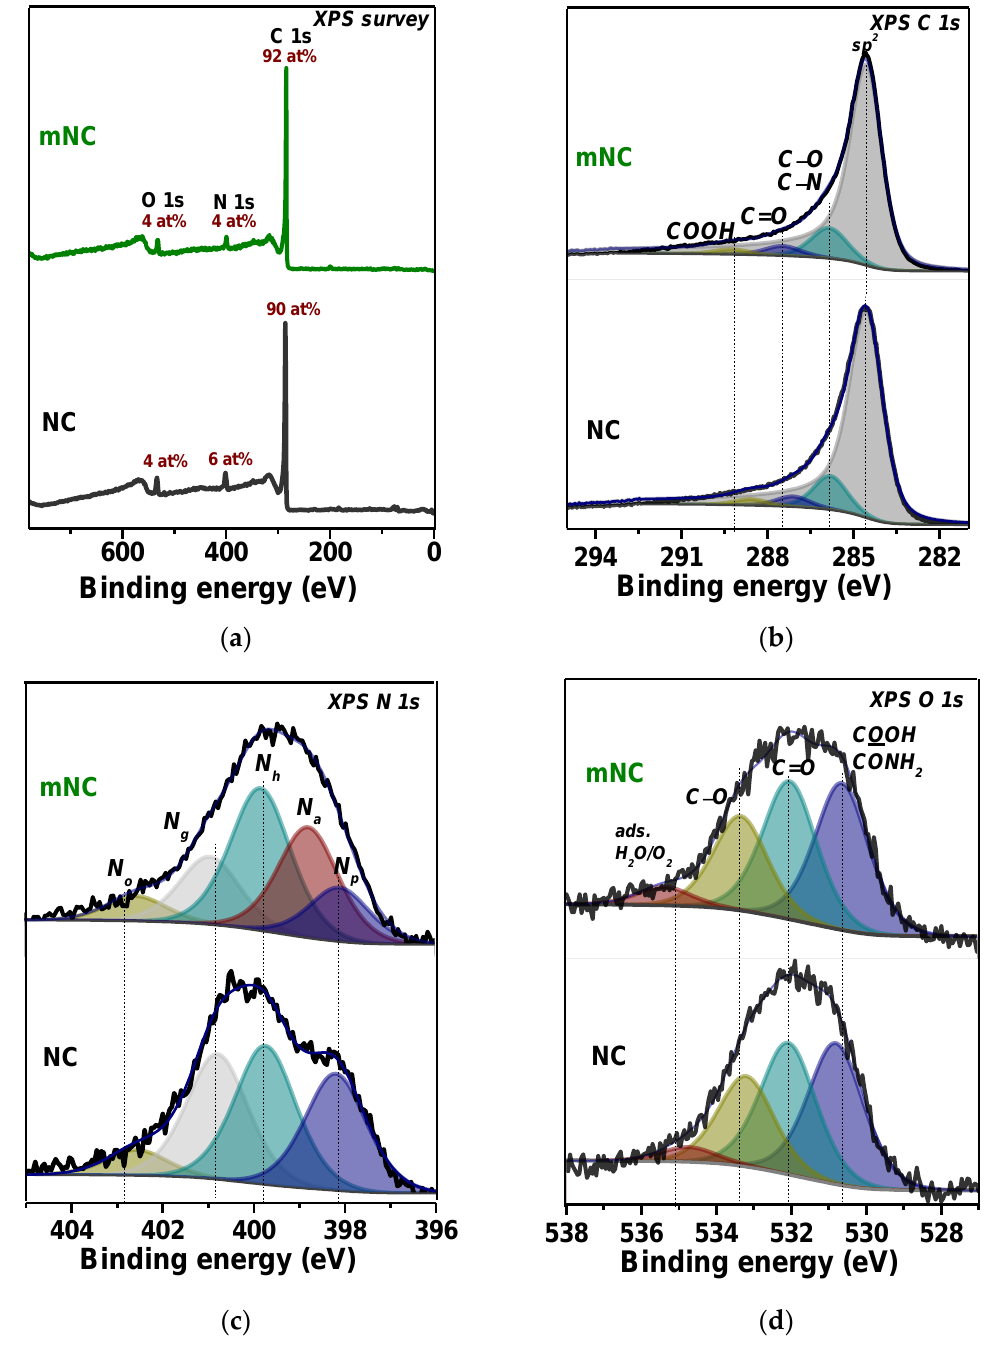
Figure 2. XPS ( a ) survey, ( b ) C 1s, ( c ) N 1s and ( d ) O 1s spectra of NC and mNC. The C 1s spectra of NC and mNC contain four components (Figure 2b) originating from sp 2 -carbon (284.5 eV), defect states and carbon bonded with oxygen or nitrogen (286.0 eV), carbon double-bonded with oxygen (287.3 eV), and carboxylic carbon (288.5 eV). The components have similar energy position, width, and area in both spectra. The N 1s spectra of NC and mNC are approximated by four or five components of the same width, as shown in Figure 2c. Four nitrogen forms are found in the initial sample NC: pyridinic N at 398.1 eV (N p ), hydrogenated pyridinic N at 399.8 eV (N h ), graphitic N at 400.9 eV (N g ), and oxidized nitrogen species at 402.7 eV (N o ) [58]. The ratio of N p :N h :N g :N o is 1:1:1:0.2. The N 1s spectrum of mNC contains the above components and a new component (N a